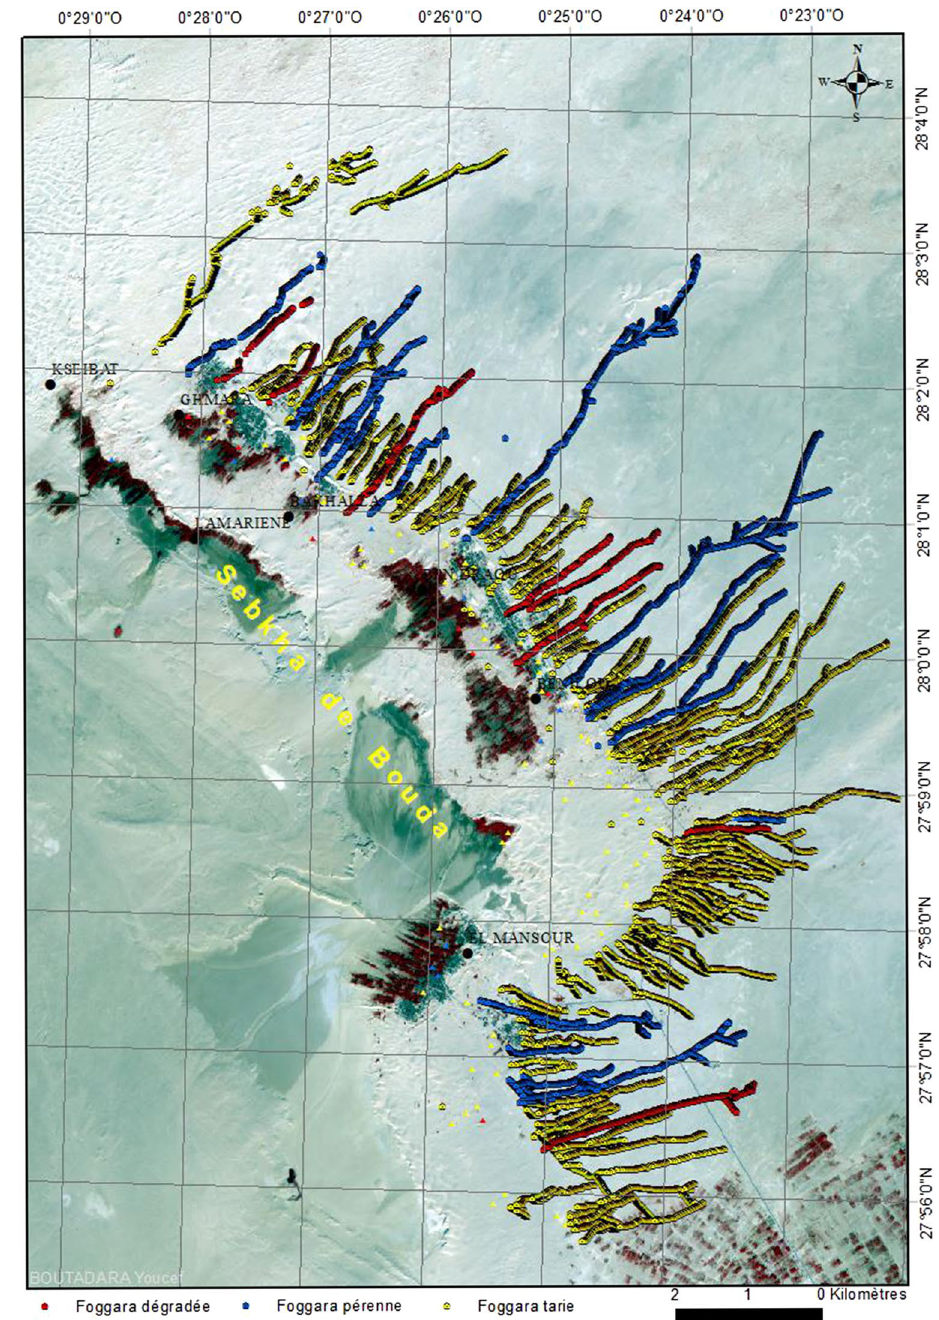
Fig. 23 Situation of the fogga- ras of the oasis of Bouda. (own